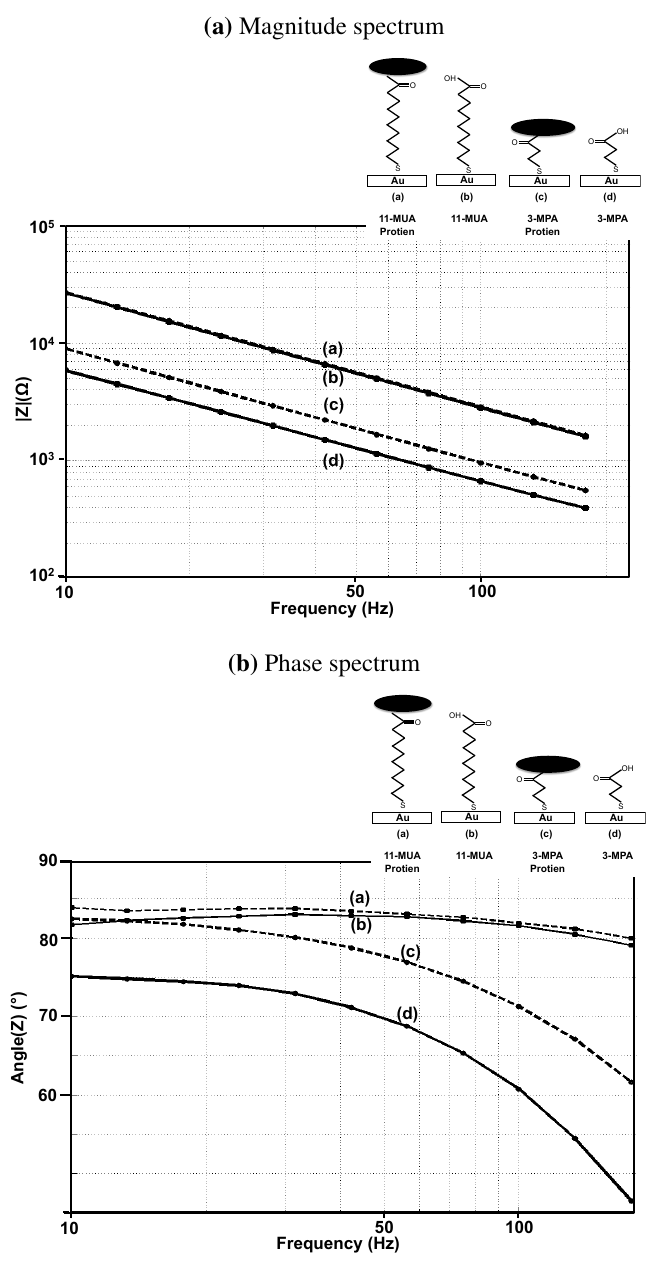
Figure 10. Experimental determination of magnitude and phase spectrum of (a) 11-MUA with protein attached (b) 11-MUA only (c) 3-MPA with protein attached (d) 3-MPA